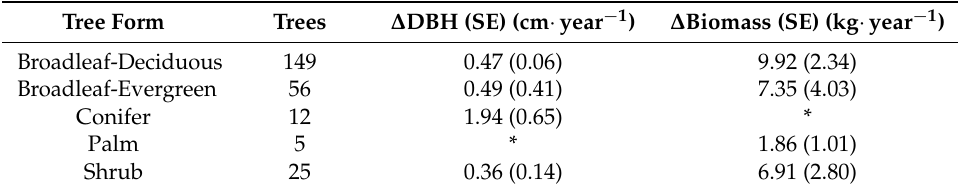
Table 6. Annual average change in growth diameter rate ( ∆ DBH) and aboveground biomass for different tree forms in Santiago Chile during 2002 to 2014.